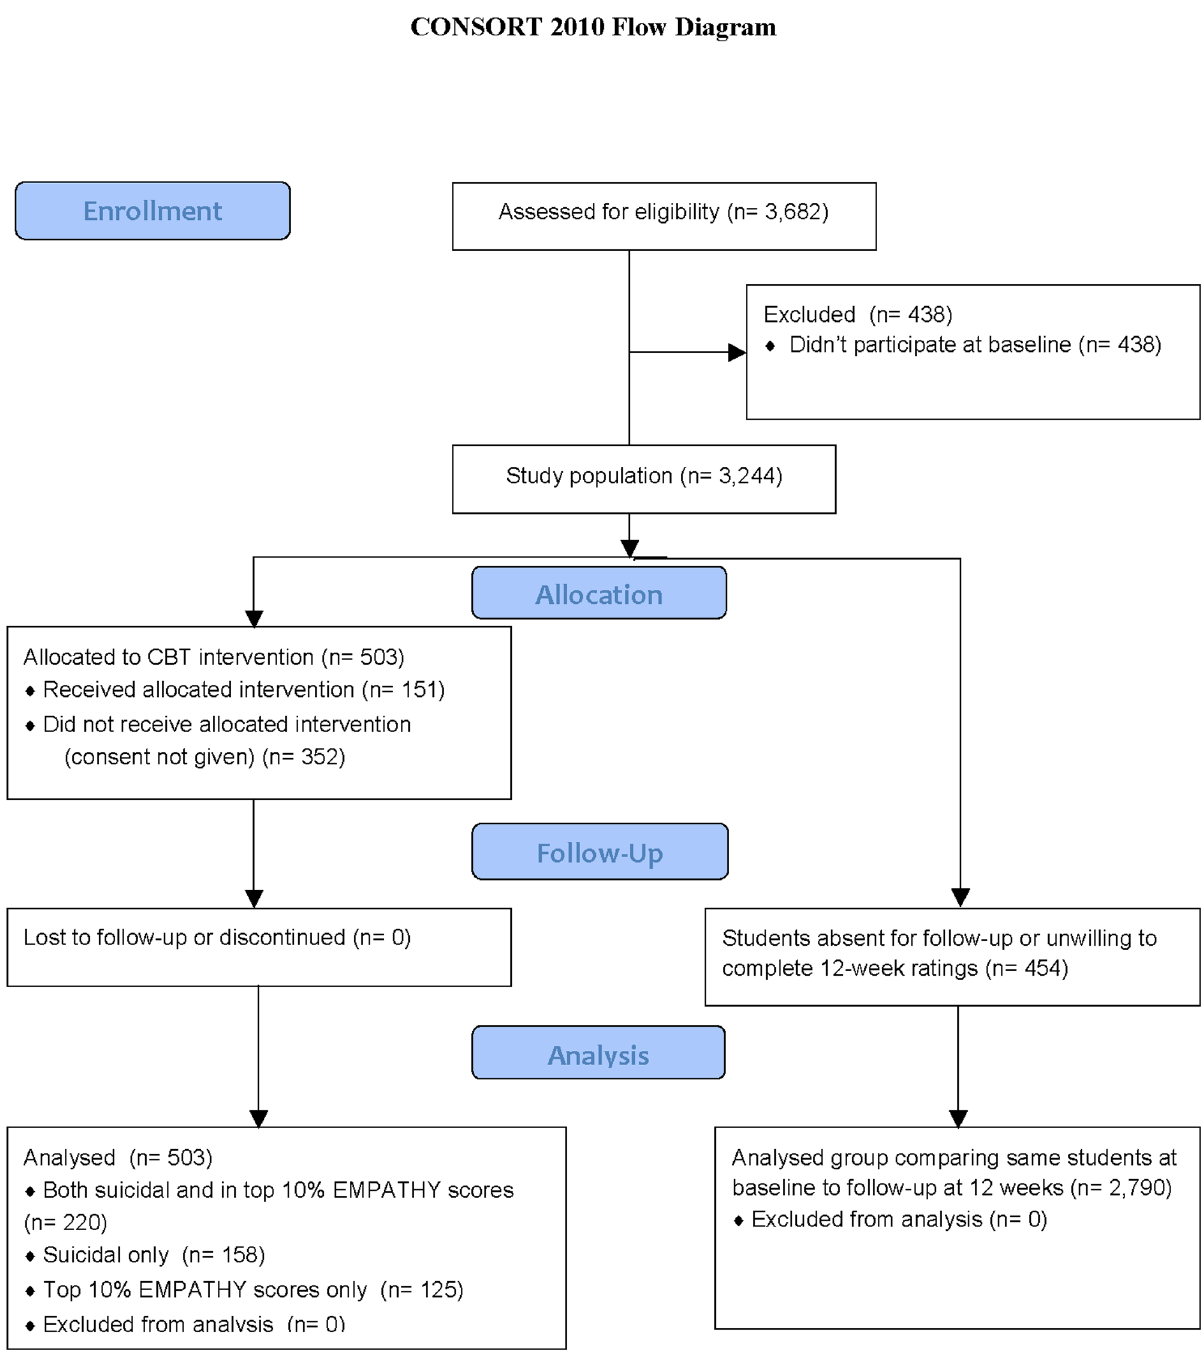
Fig 1. Consort flow chart demonstrating allocation of students. The figure shows how many students entered the study and (on the left-hand side) how many were allocated to the CBT treatment as well as (on the right-hand side) how many completed both baseline and 12-week follow-up ratings and formed the study